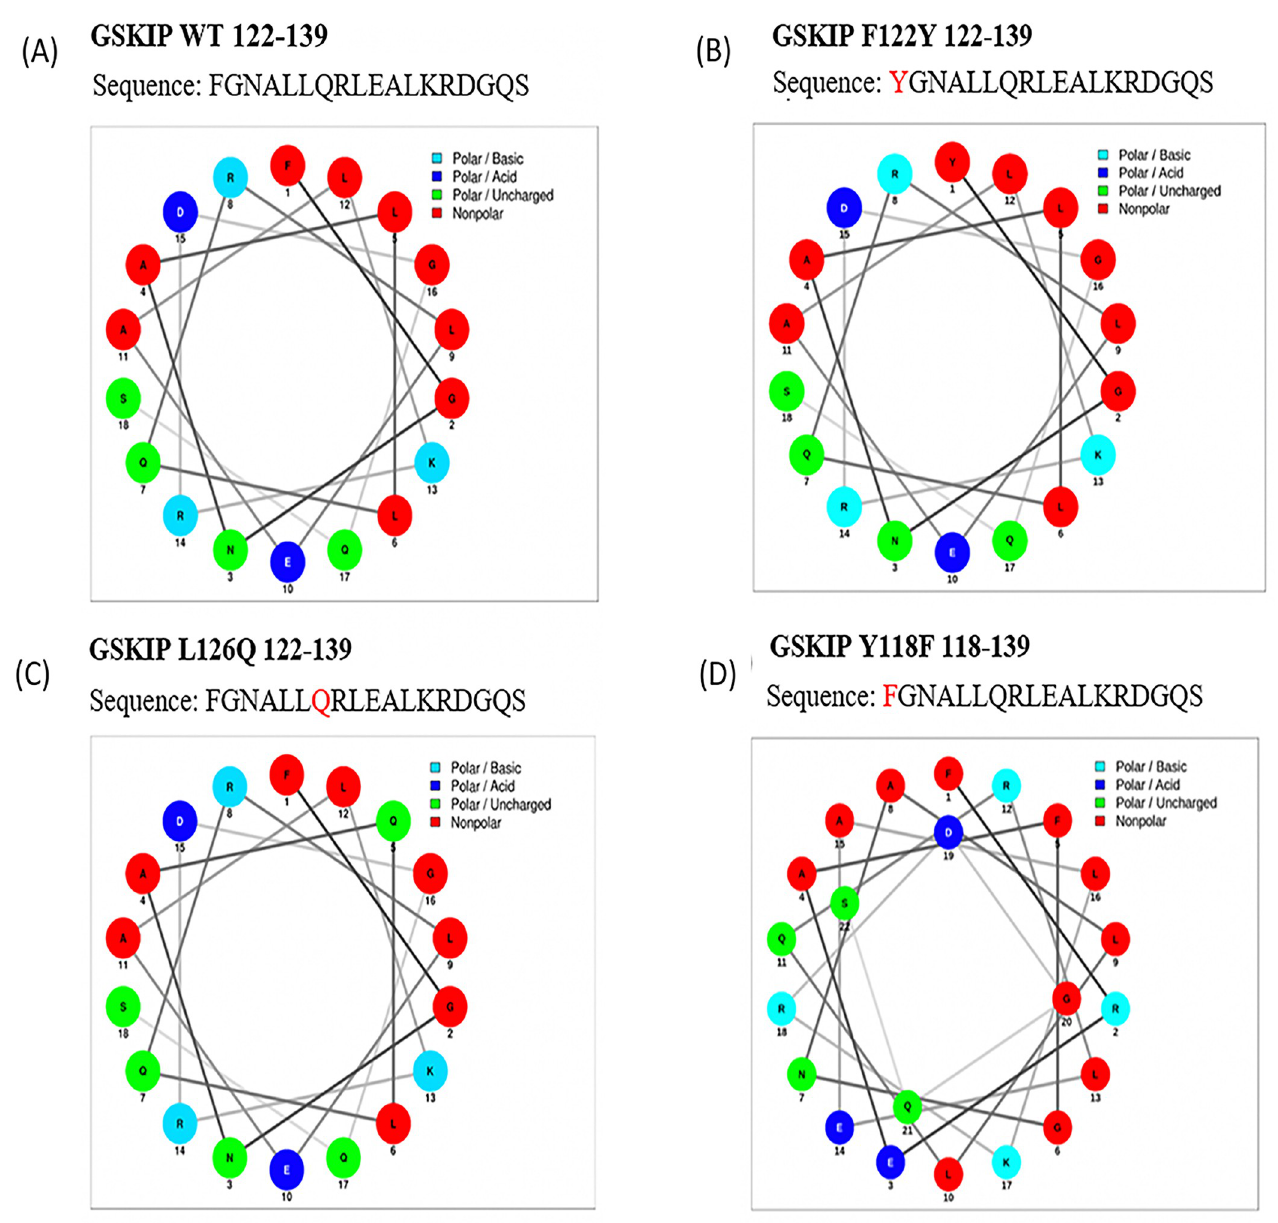
Fig 4. Helical wheel analysis of GSKIP wt and various GSKIP mutants at amino acid sequence 122–139, which harbors the GSK3 β -binding site. A, GSKIP wt. B, GSKIP L126Q mutant. C, GSKIP F122Y mutant. D, GSKIP Y118F mutant.